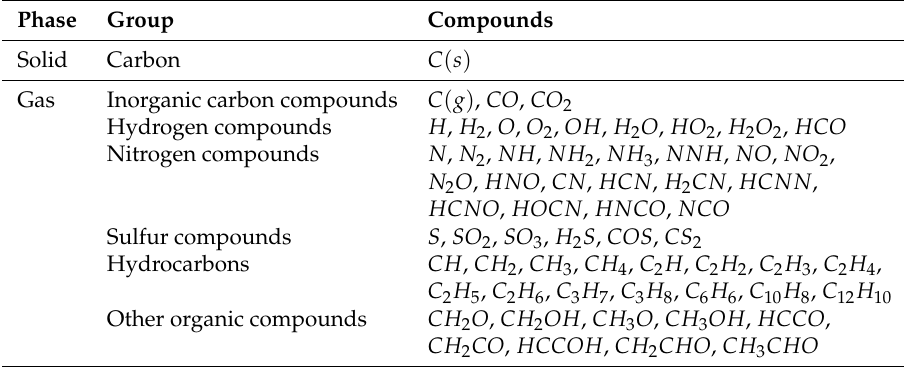
Table 2. Chemical species considered in the applied equilibrium model (modified after Baratieri et al. [16]).